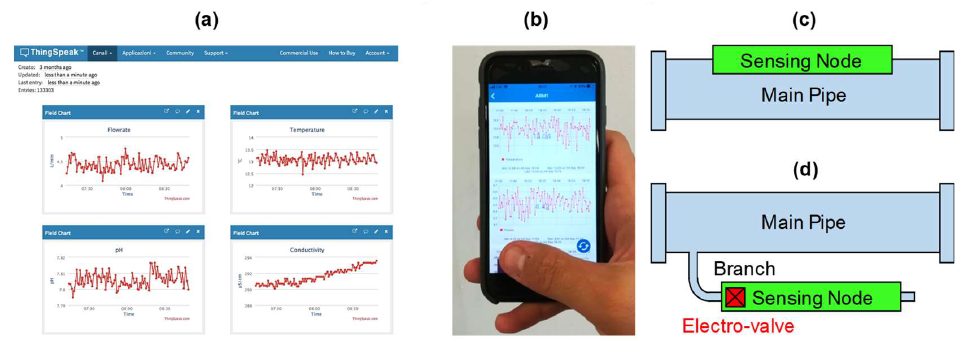
Figure 2. User interface of the ThingSpeak ™ Cloud displaying in real-time acquired data on a password-protected website ( a ) and on smartphone app ( b ). Possible installation approaches of the sensing node: ( c ) in the main pipe or ( d ) in a derivation branch, whose flow can be